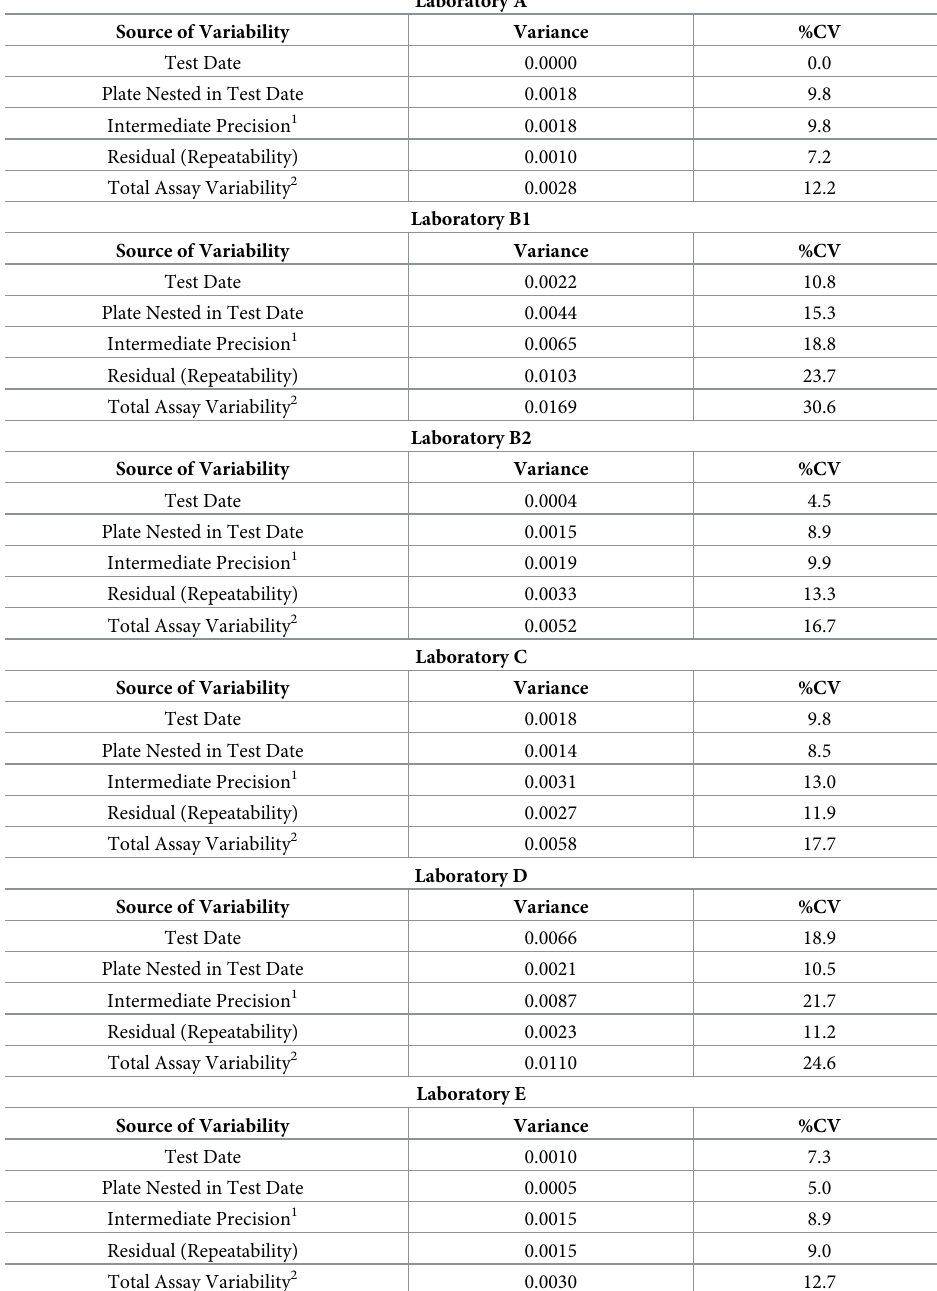
Table 5. Summary of variance components obtained from mixed ANOVA model fit to data from all laboratories (results shown by